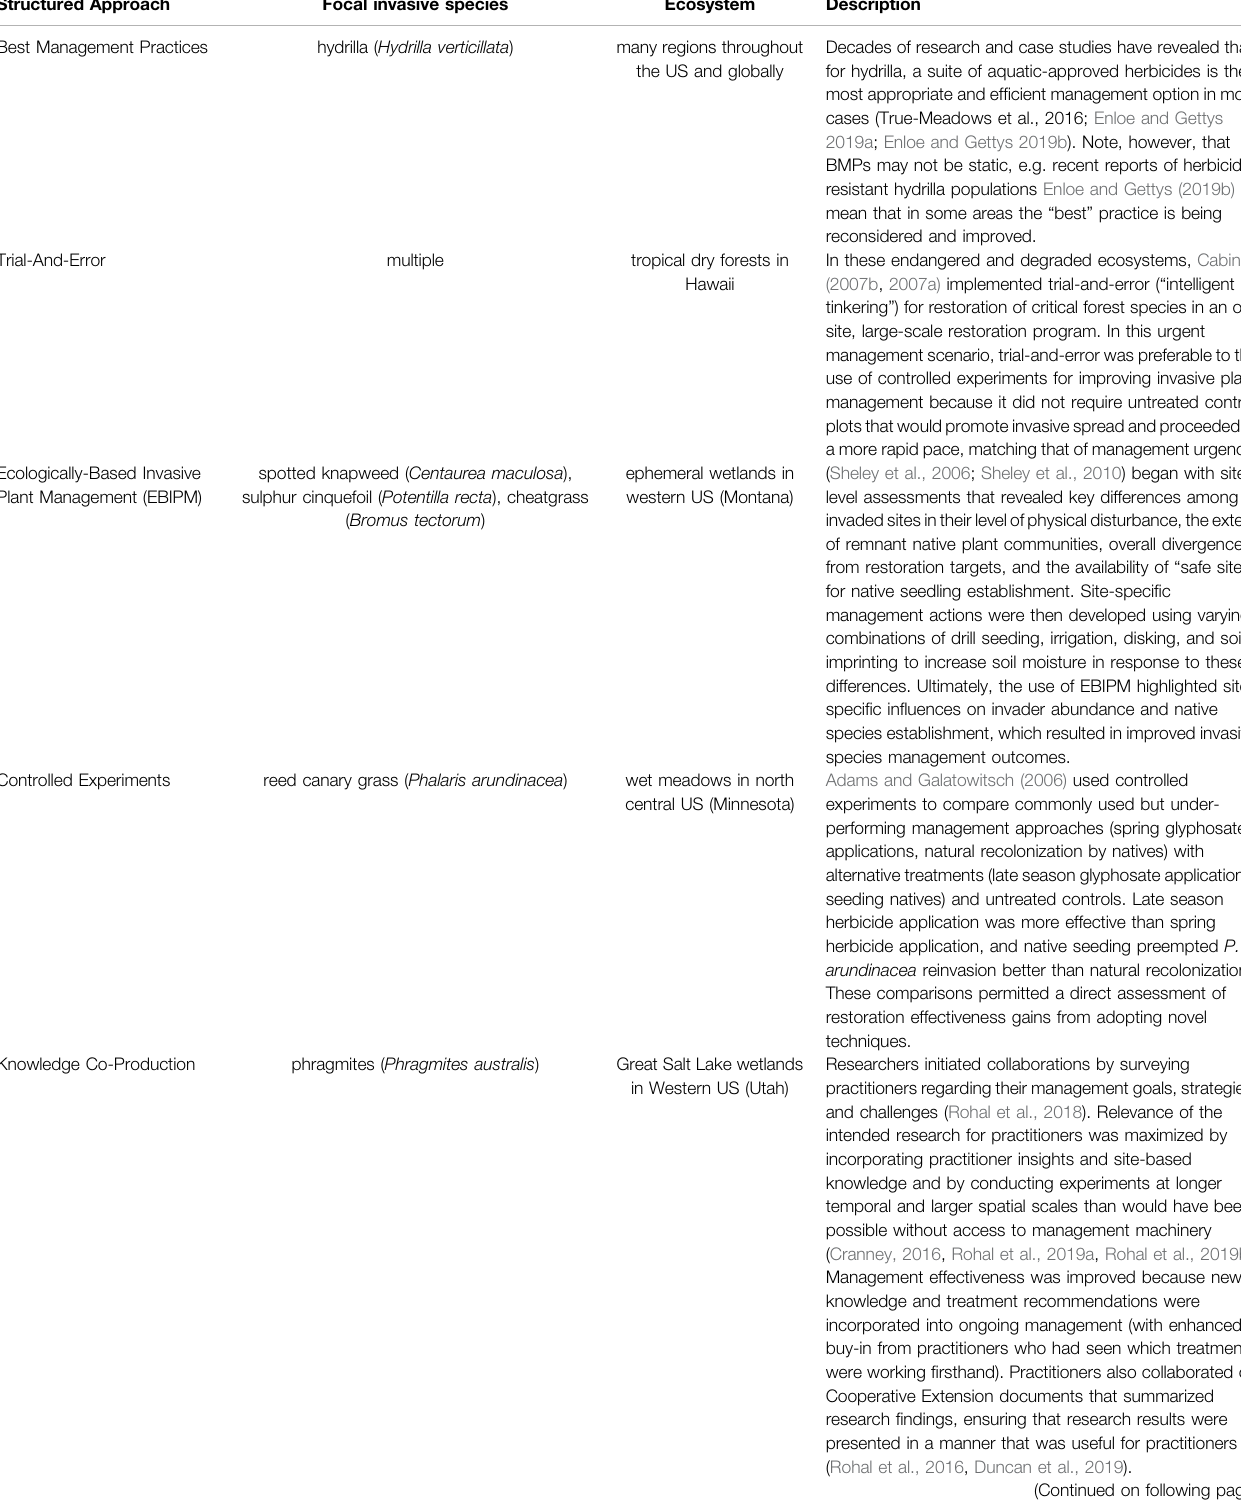
TABLE 1 | For each of the seven Structured Approaches we describe in the text, an example of its implementation from is provided here; examples in peer-reviewed journal articles were prioritized. Wherever possible, these examples are drawn from approaches taken to manage invasive species in wetlands; however, we emphasize that none of these approaches are ecosystem-speci fi